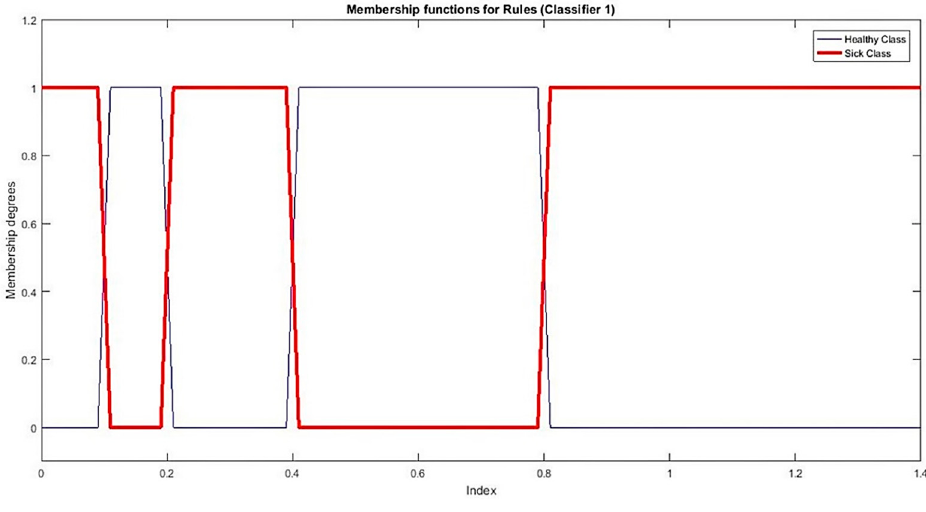
Figure 5. MFs for classifier 1.